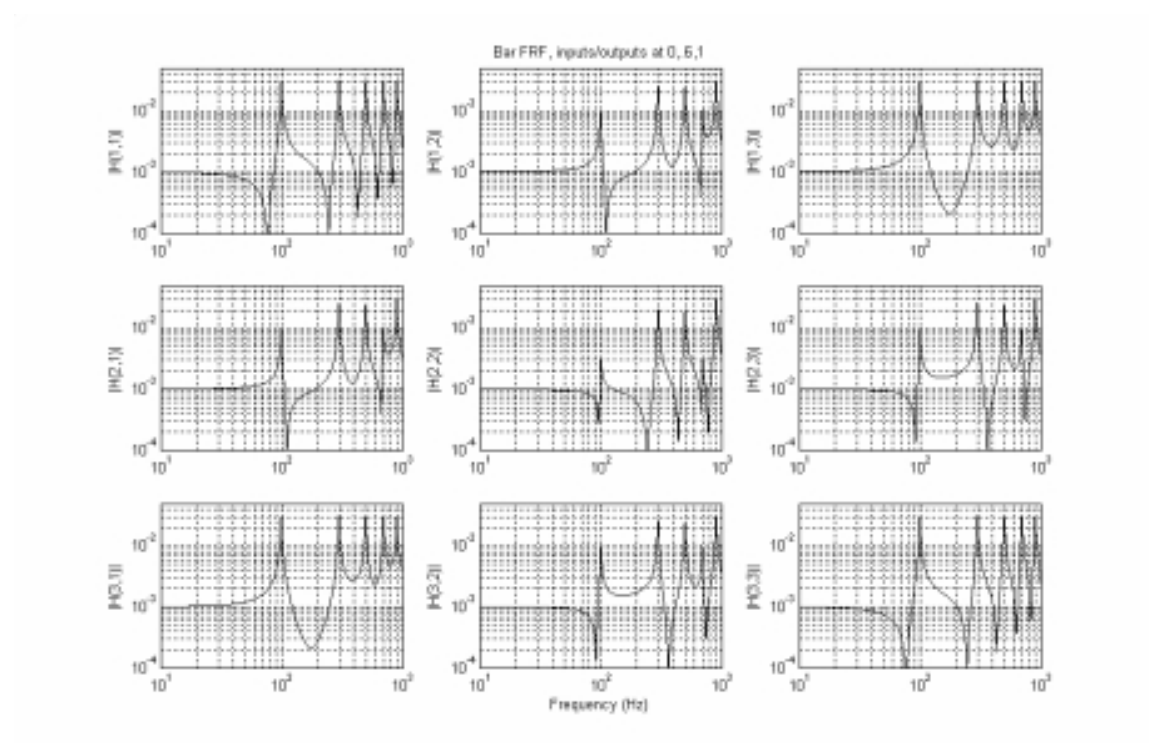
Fig. 4. FRF’s, bar, magnitude